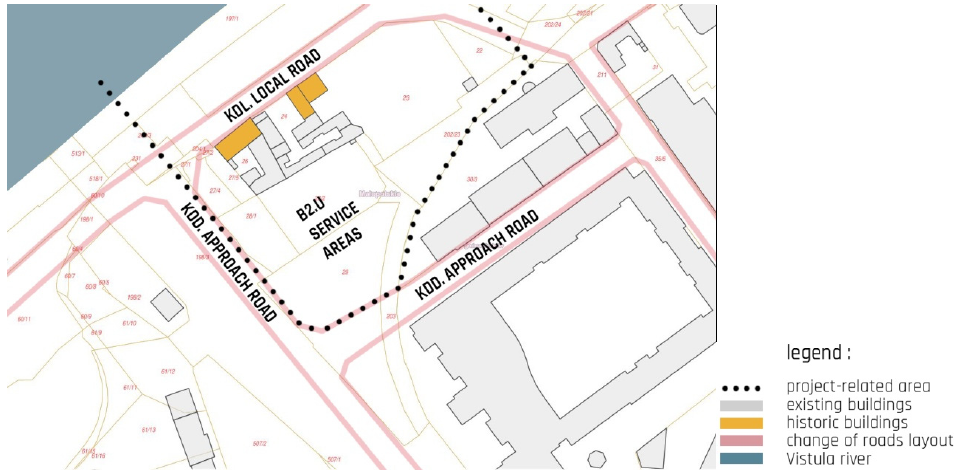
Figure 17. Plots constituting the main part of the development of the concept of a multi-functional complex with objects and sites under the conservation (elaborated by E. Latusek).